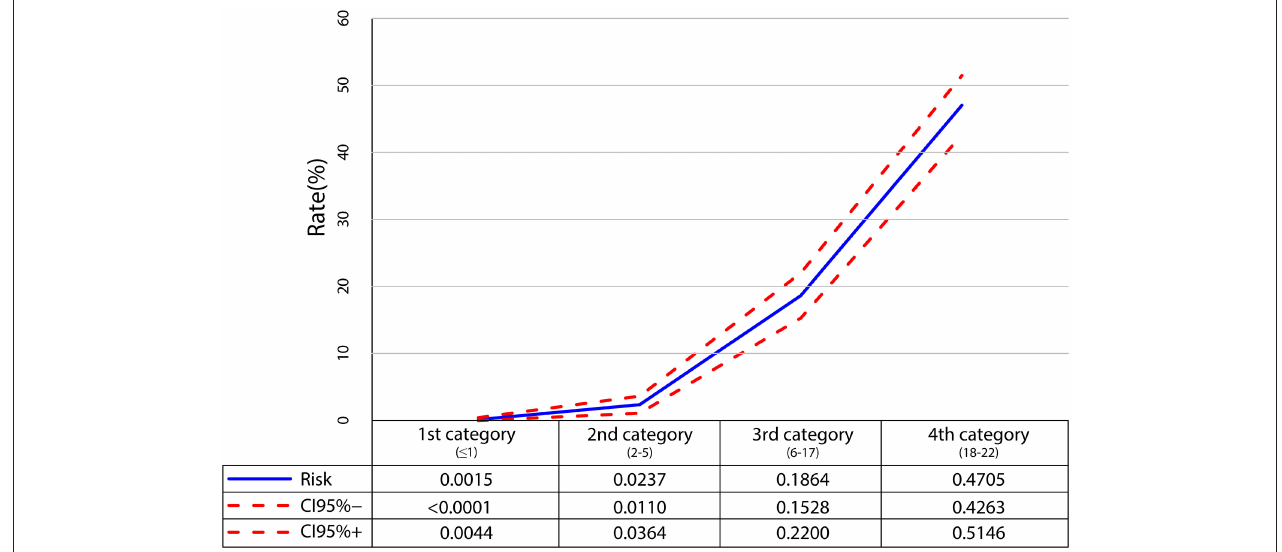
FIGURE 2 | Probability of developing urinary tract infection for particular risk